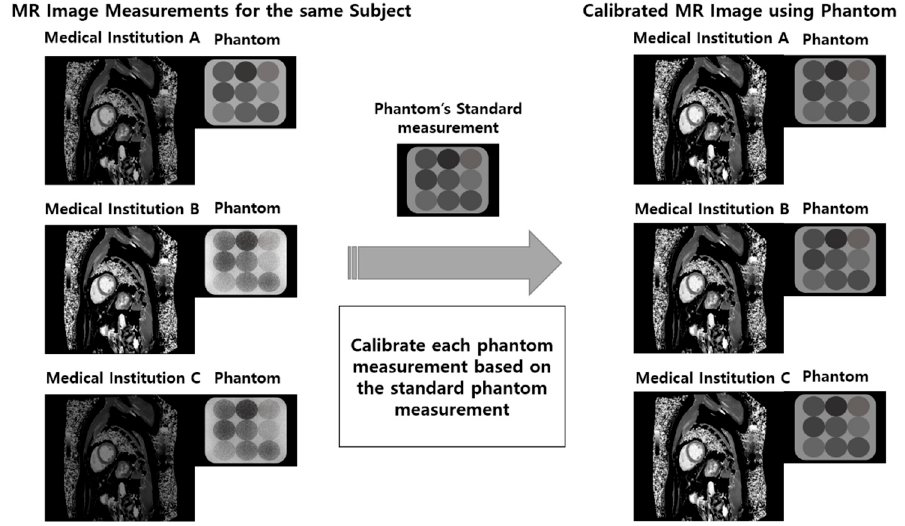
Figure 13. Example of Minimization of Medical Imaging Measurement Uncertainty Elements.